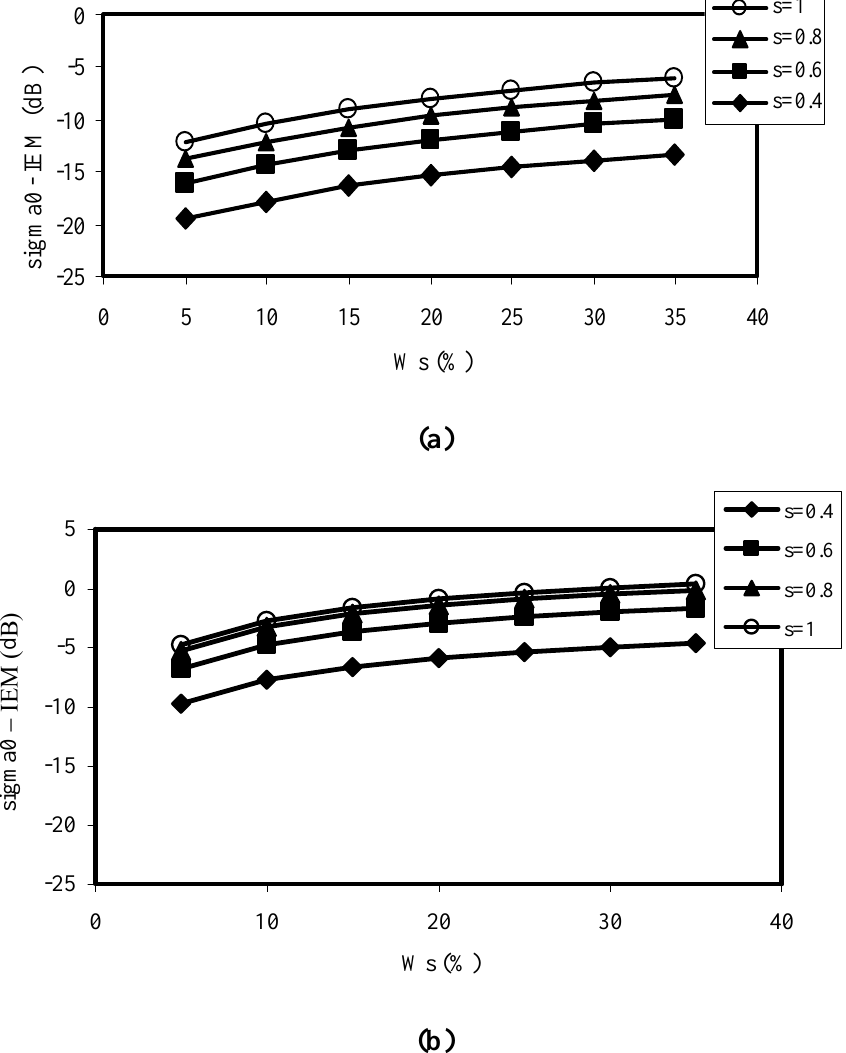
Figure 7. Illustration of IEM simulations, with a classical computation of the dielectric constant, for different values of roughness, as a function of soil moisture. (a) L band (1.25 GHz), (b) C band (5.3